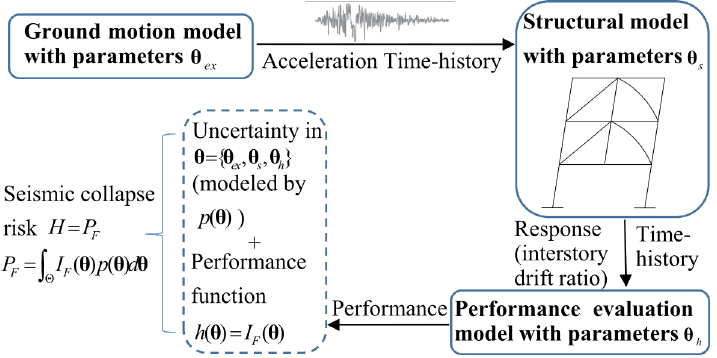
Figure 1. Augmented system model for seismic collapse risk